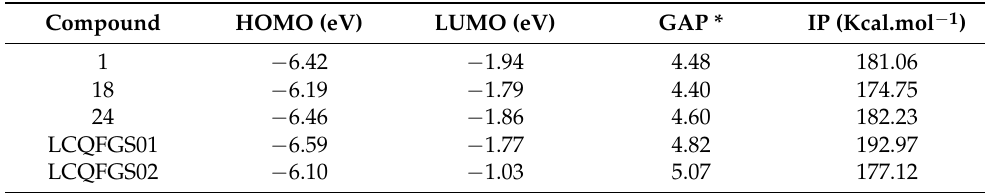
Table 4. Calculated quantum chemical properties for the five selected compounds using DFT/